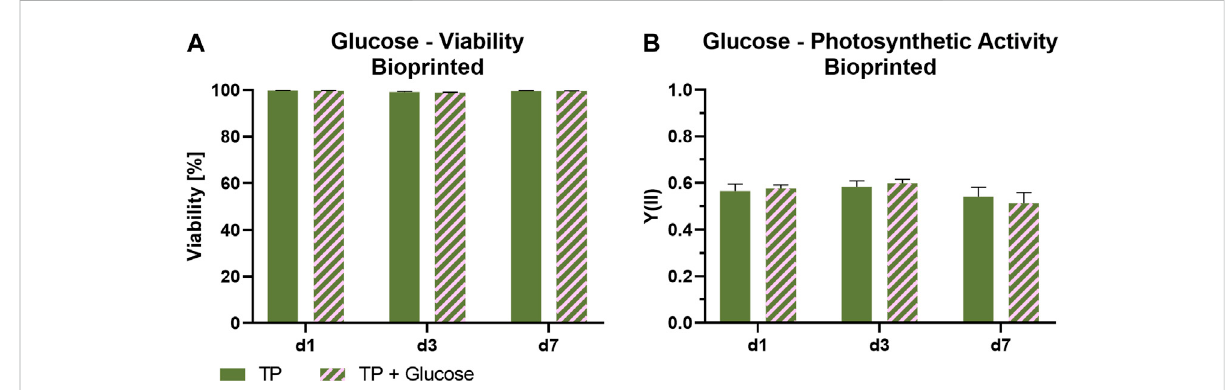
Figure 7C displays the glucose concentration in both media at the start of